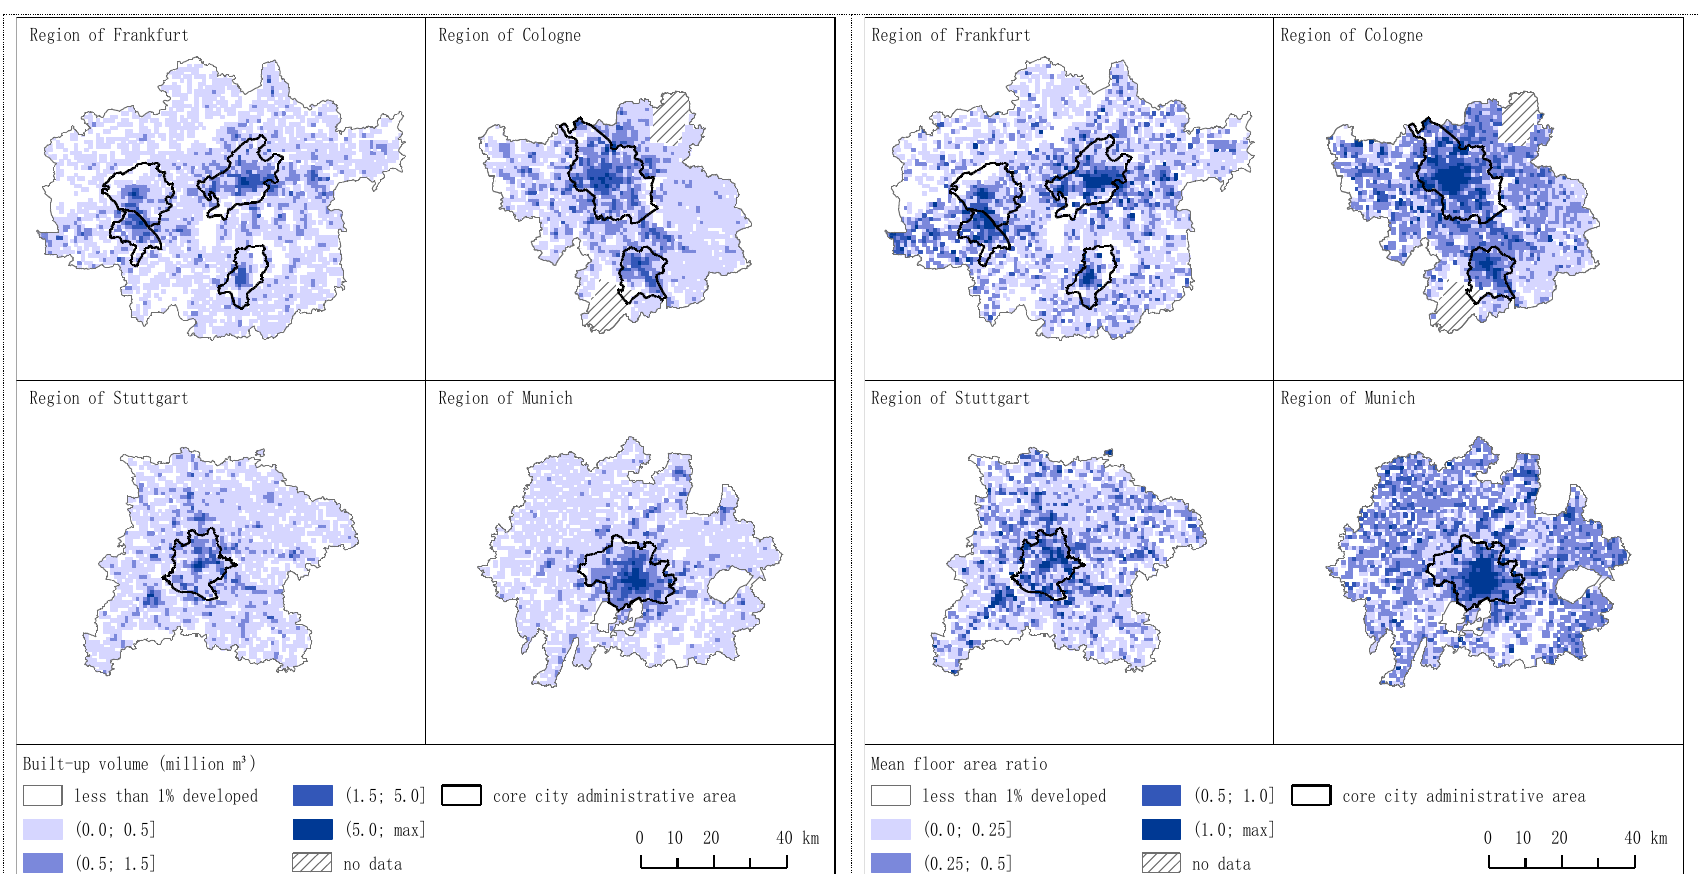
Figure 7. Patterns of built densities represented by built-up volume ( left ) and mean floor area ratio ( right ) for 1-km 2 grid cells.